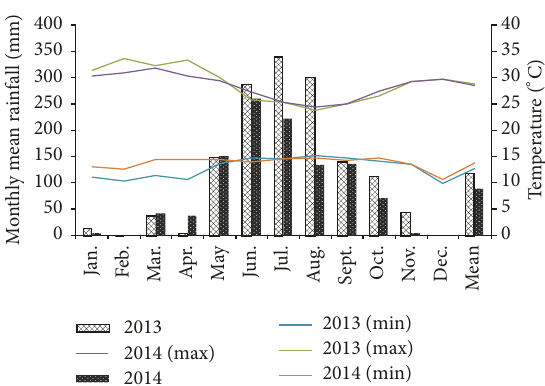
Figure 1: Mean monthly rainfall and minimum and maximum temperature of Bako research site, 2013-2014.